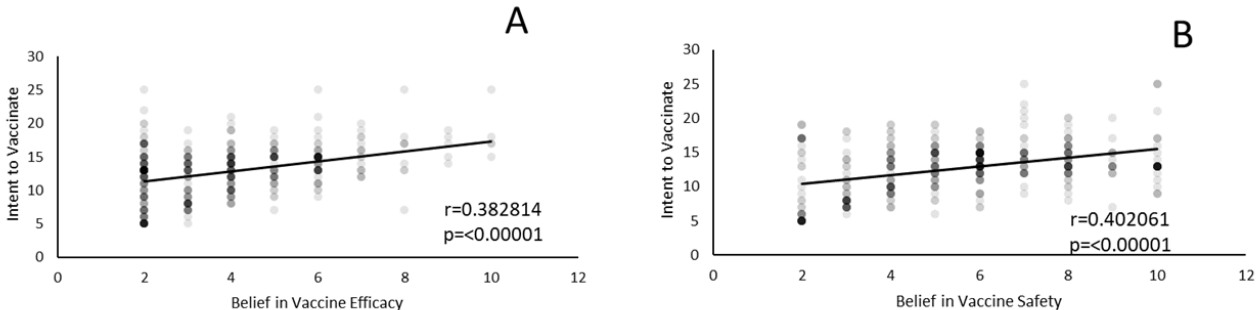
Figure 4. Intent to vaccinate correlates with views of safety and efficacy: There is a strong correlation between an individual’s intent to vaccinate their children against HPV and beliefs in the safety and efficacy of HPV vaccines. The y-axis indicates intent to vaccinate, and the x-axis indicates beliefs in the safety and efficacy of the vaccine. ( A ) Individuals who believe that the vaccine is effective have a higher intent to vaccinate their children (r = 0.3828, p ≤ 0.00001). ( B ) Individuals who believe that the vaccine is safe have a higher intent to vaccinate their children (r = 0.4021, p ≤ 0.00001).